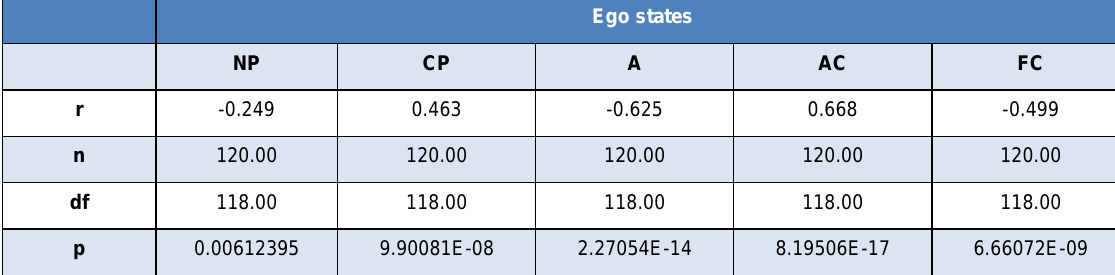
Table 7: Significance testing of r: Ego states and Neuroticism